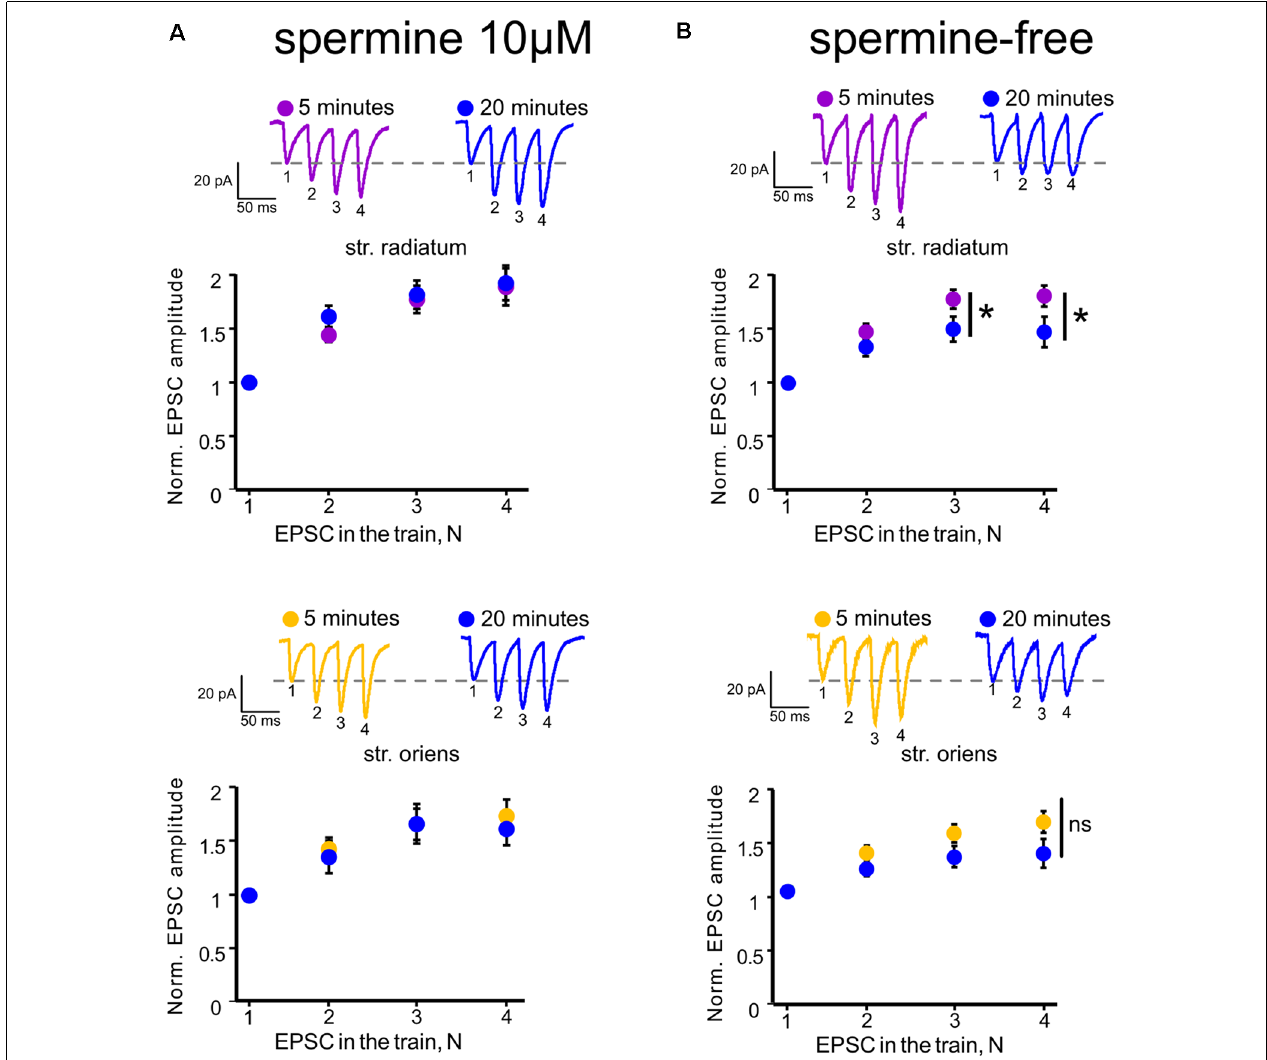
FIGURE 2 | Polyamine-dependent facilitation at the synapses of CA1 pyramidal cells. (A) Polyamine-dependent facilitation at apical (upper) and basal (lower) dendrites recorded with spermine-containing intracellular solution 5 and 20 min after whole-cell patch establishment, n = 6 cells from four animals. (B) Polyamine-dependent facilitation at apical (upper) and basal (lower) dendrites recorded with spermine-free intracellular solution 5 and 20 min after whole-cell patch establishment, n = 8 cells from five animals, * p ≤ 0.05; ns, nonsignificant. Averaged traces of responses to stimuli with a 33-ms interstimulus interval at the indicated times are displayed above each graph. EPSC numbering corresponds to the x-axis of each